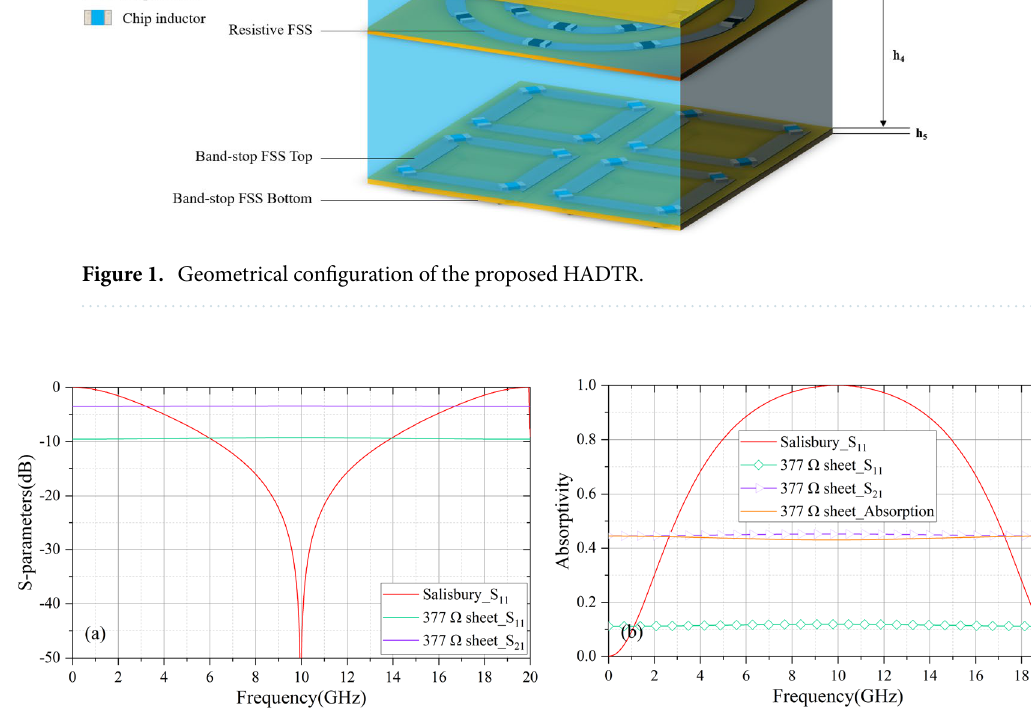
Figure 2. At normal incidence, under TE polarization. ( a ) reflection coefficient of a Salisbury Screen with ε 0 = 1.0, d 1 = 7.50 mm, and the reflection/transmission coefficient of a 377 Ω/sq sheet; ( b ) the absorptivity of the Salisbury Screen and the reflectance, transmittance, and absorptivity of the 377 Ω/sq sheet. (R =|S 11 | 2 , T =| S 21 | 2 , A = 1 −|S 21 | 2 −|S 11 | 2